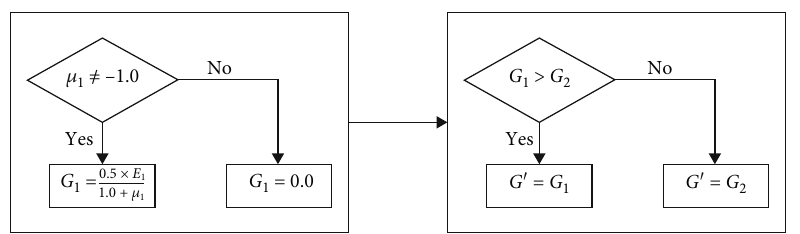
Figure 9: Logic relationship of the shear modulus conversion.